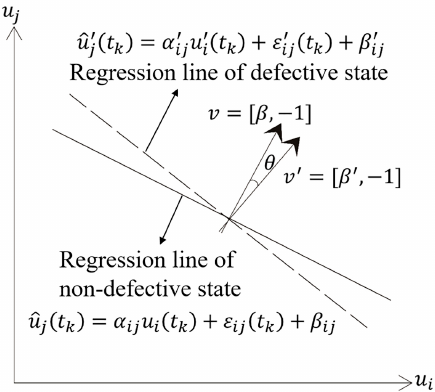
Figure 1. Geometric significance of the damage indicator θ in a single-variable regression (SVR) model.